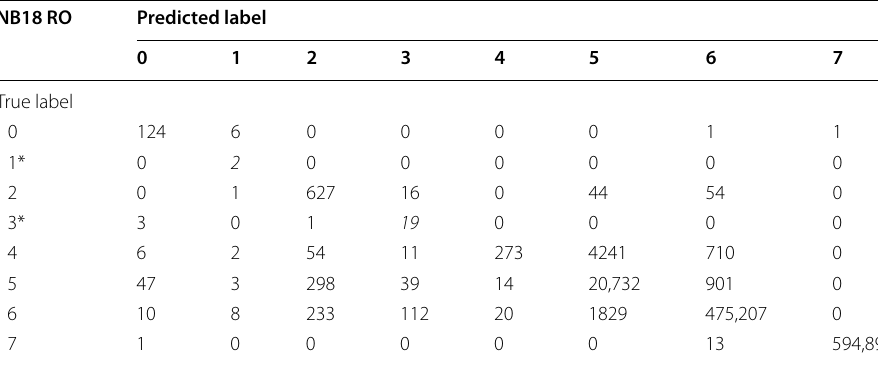
Table 33 Confusion matrix: NB18